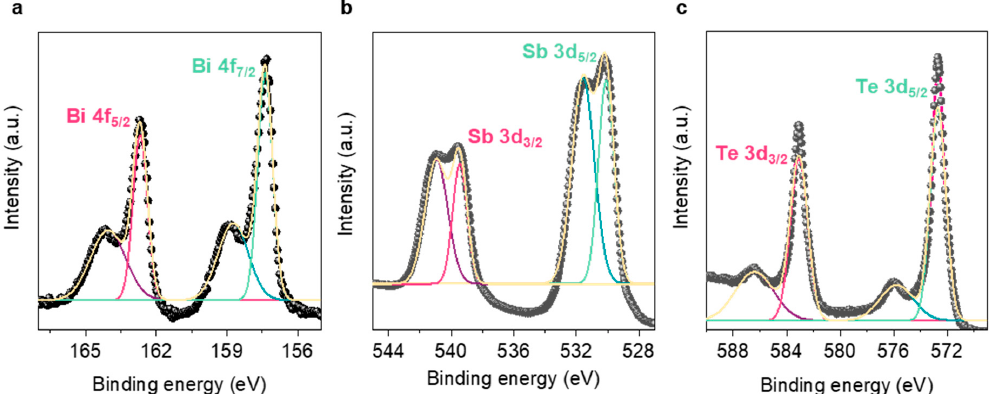
Figure 3. High-resolution X-ray photoelectron spectroscopy (XPS) spectra of ( a ) Bi 4f, ( b ) Sb 3d, and ( c ) Te 3d orbitals.